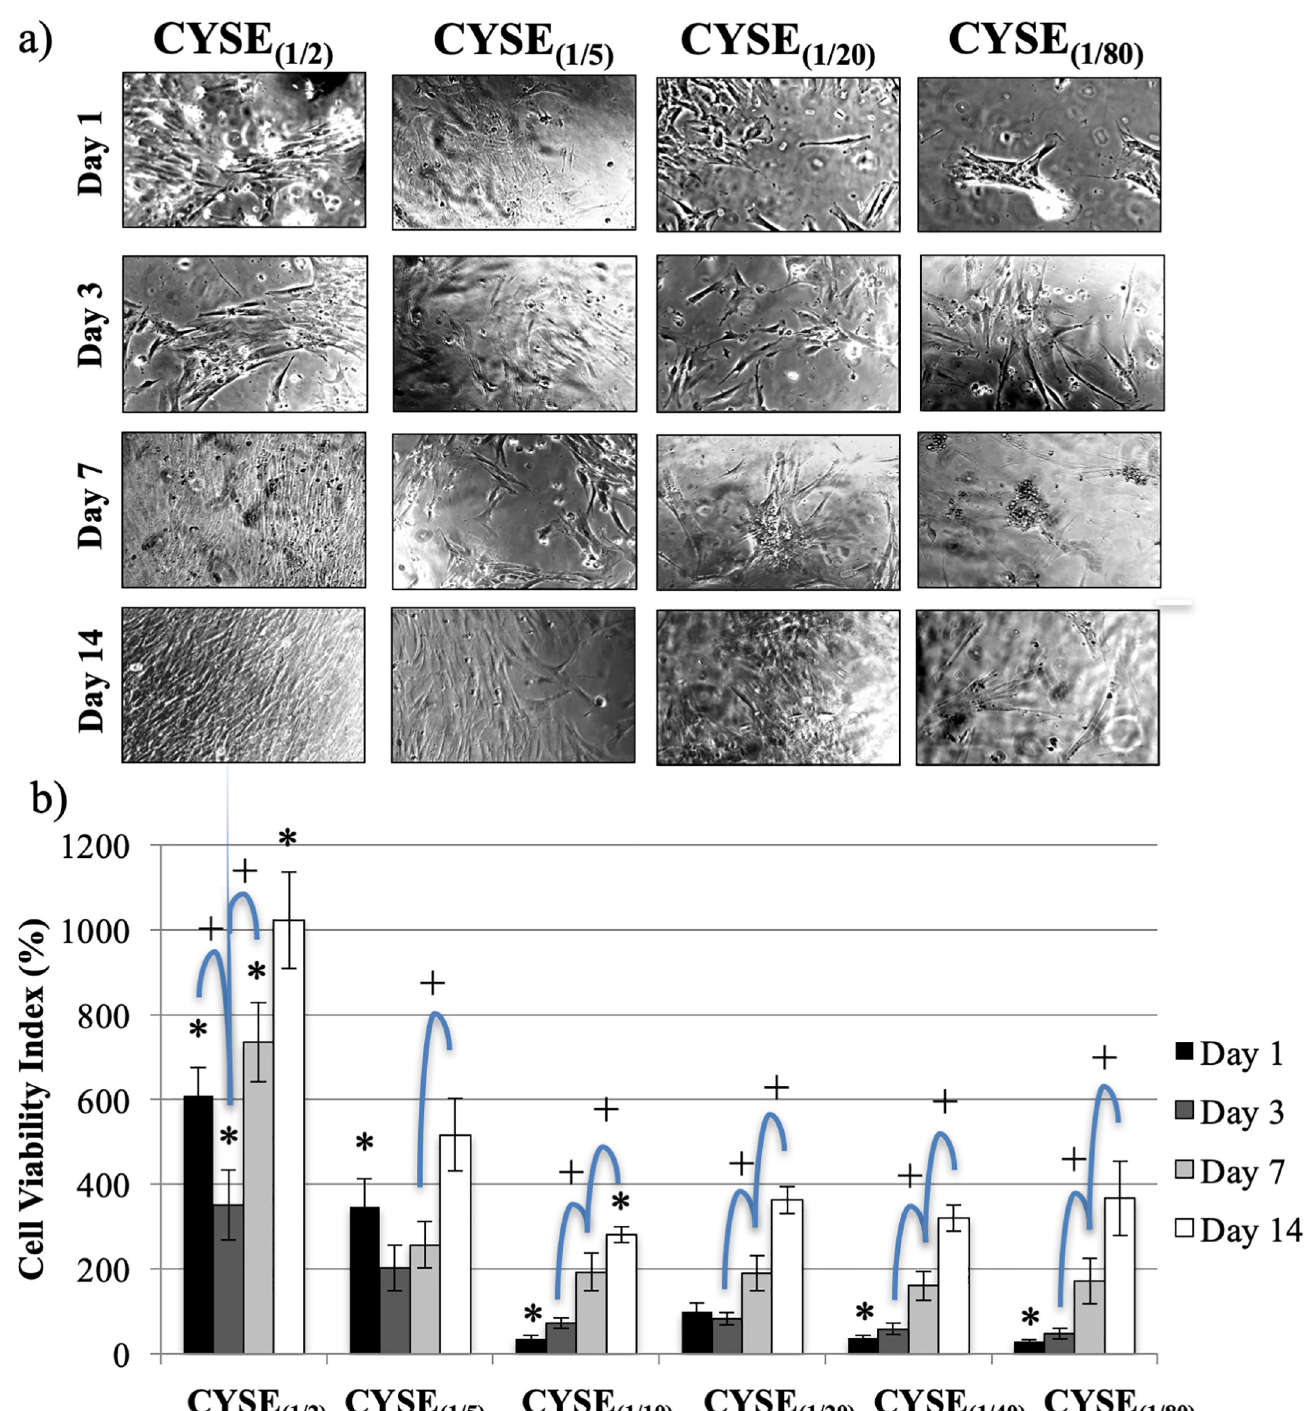
Fig 4. a) Phase-contrast microscopic pictures of PDL cells on PASP hydrogel discs containing different quantity of thiol groups. b) PDLC viability measured 1, 3, 7 and 14 days after seeding. The average viability value measured on the CYSE (1/20) gels on day 1 was considered as 100%. Data are given as an arithmetic mean ± SEM (standard error of the mean). � p < 0.05 compared to CYSE(1/20) at the appropriate time point. +p < 0.05 compared to the next day values. Each photomicrograph was taken at the same magnification. The scale bar indicates 100 μ